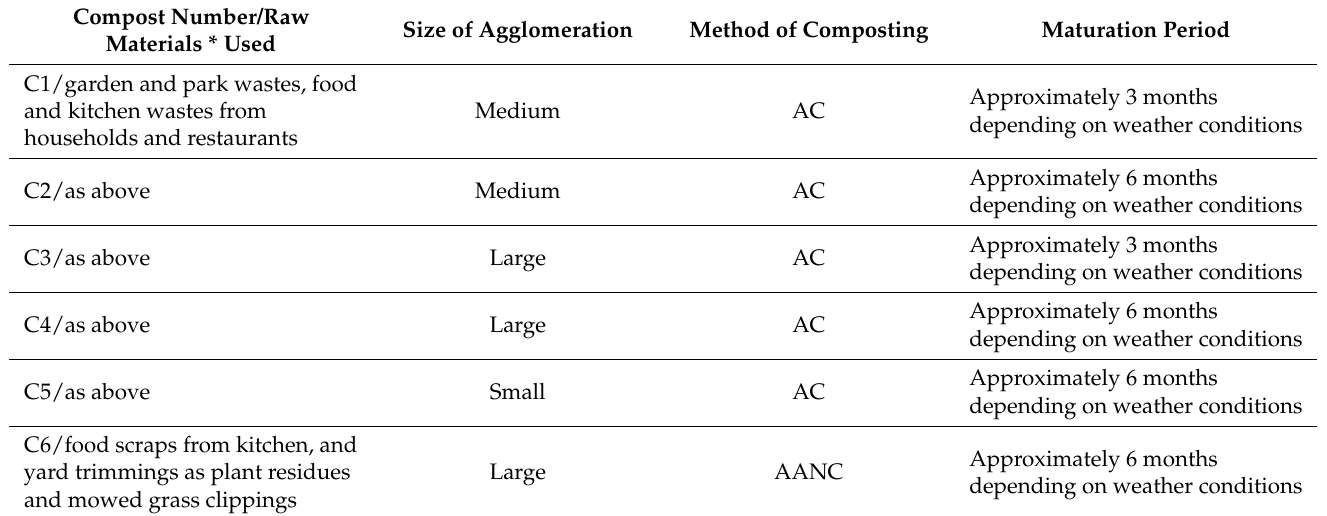
Table 2. Characteristics of composting process